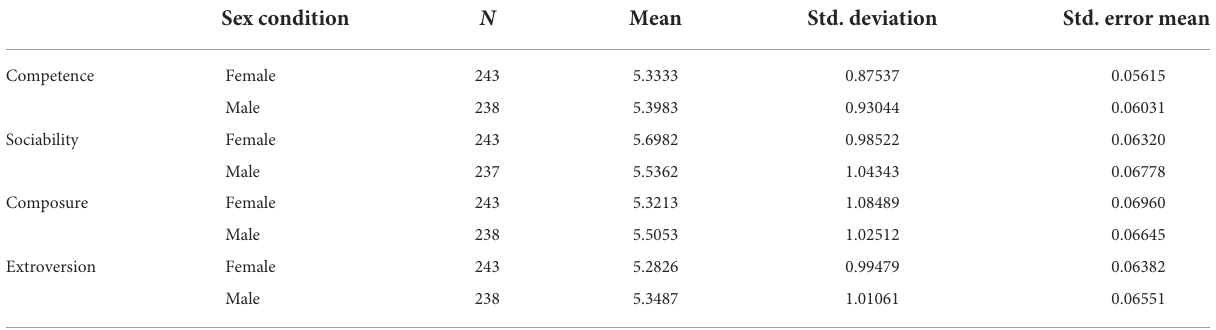
TABLE 1 Experiment 1 – group statistics.